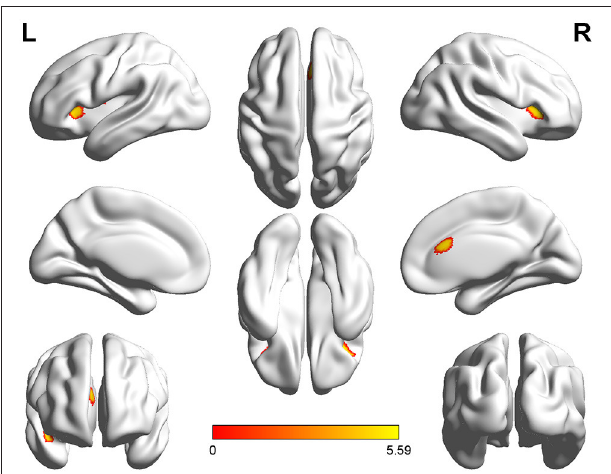
FIGURE 1 | Three-dimensional images made by BrainNet Viewer based on the result of VBM. Regions showing significant higher GMV in healthy controls compared with the patients with SCI [cluster level, family-wise error (FWE) p ≤ 0.05]: dorsal anterior cingulate cortex (dACC), bilateral anterior insular cortex (aIC), bilateral orbital frontal cortex (OFC), and right superior temporal gyrus